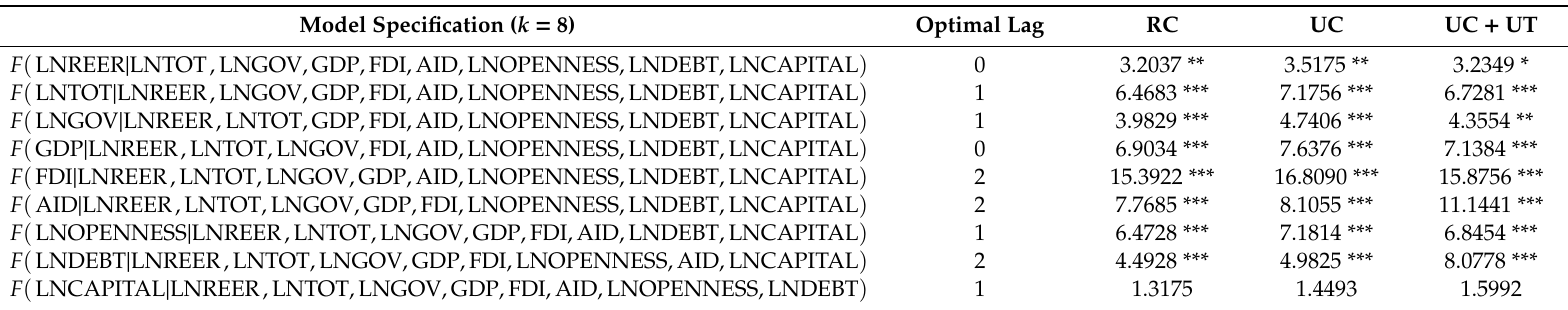
Table 1. Results of the F -test for the long-run relationship between the real e ff ective exchange rate (LNREER) and its